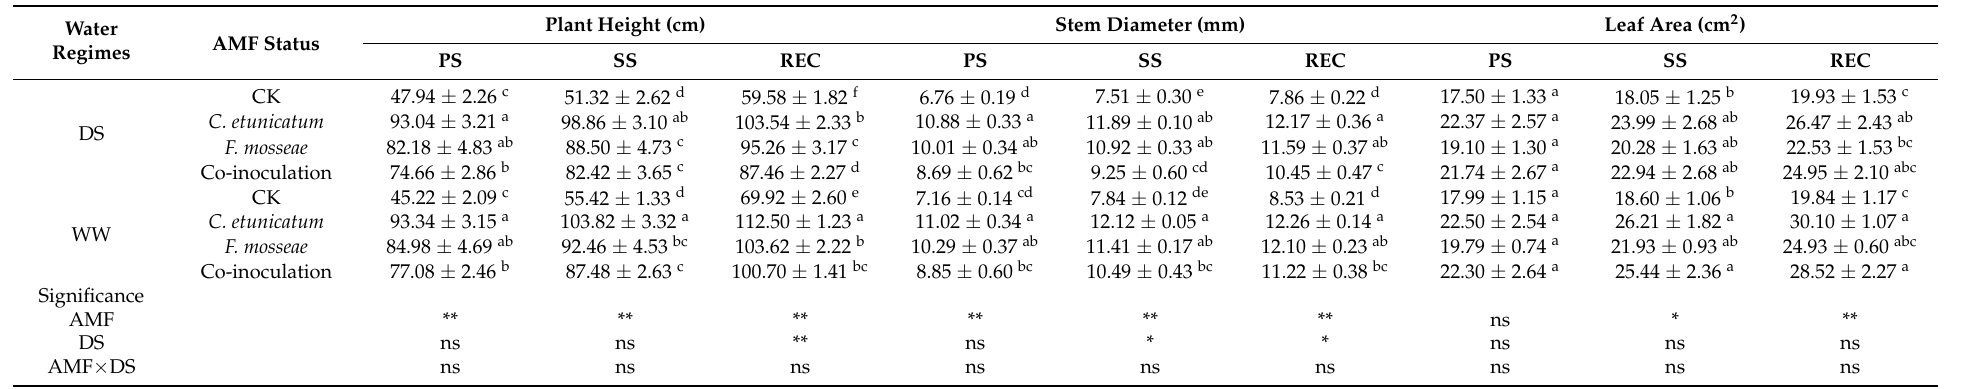
Table 1. Effect of arbuscular mycorrhizal fungus (AMF) on the Plant height, Stem diameter, and Leaf area of C. migao seedlings measured at different experiment stages. Different letters (a, b, c, d, e, f) indicate a significant difference in Tukey’s post hoc test (** p < 0.01; * p < 0.05; ns, not significant) between all treatments. PS: prior stress, SS: subjected to drought stress; REC: rewatered; DS: drought stress; WW: well − watered. CK, non − AMF control; C. etunicatum , plants inoculated with C. etunicatum ; F. mosseae, plants inoculated with F. mosseae; Co − inoculation, plants inoculated with F. mosseae and C. etunicatum . Values are expressed as the mean ± SE ( n = 6, which are treatment